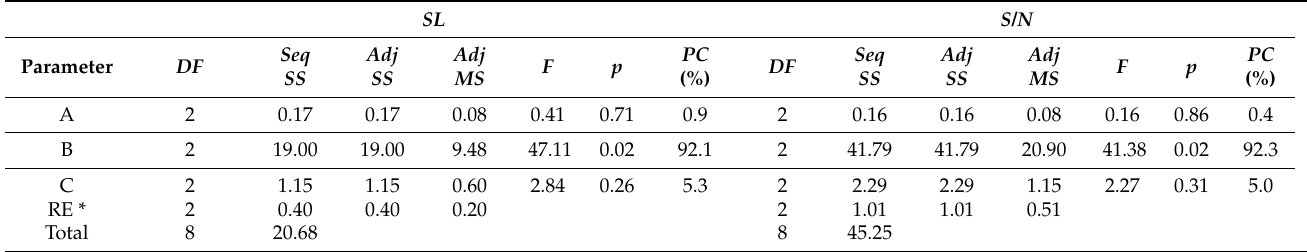
Table 2. ANOVA for SL and S / N ratio for lipid extraction from Spirulina